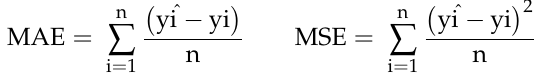
Figure 9. Comparative test results on the variation of layers Source Own elaboration.